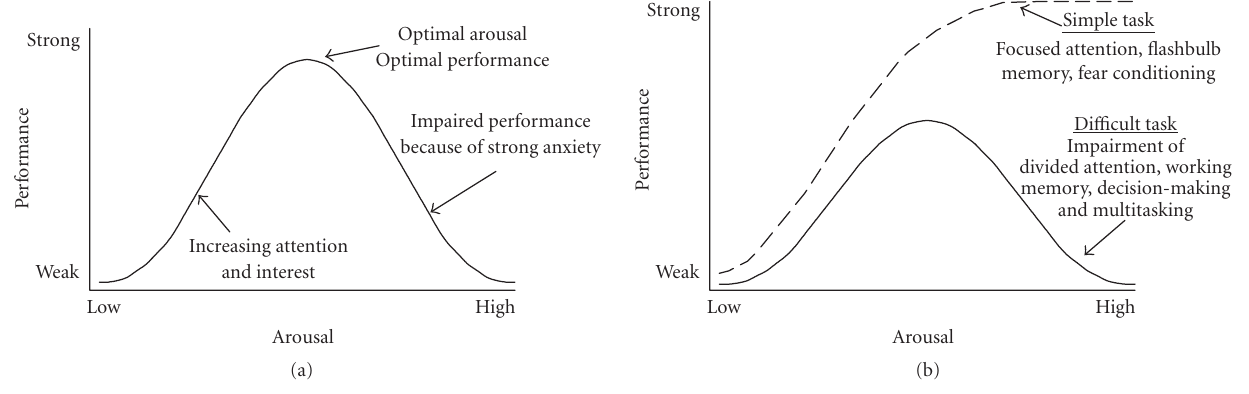
Figure 2: A comparison of the Hebbian version of the Yerkes-Dodson law, as it has been commonly represented for the past 50 years (a), and the original version, based on the actual findings and theorizing of Yerkes and Dodson ([38]; (b)). The Hebbian version incorrectly states that high levels of stress, anxiety, or motivation produce a monolithic impairment of performance. The original version based on the actual [38] Yerkes-Dodson findings takes into account the finding that strong emotionality can enhance performance under “simple” learning conditions, such as when learning involves focused attention on a restricted range of cues, and impairs performance under more complex or challenging learning situations, such as in divided attention, multitasking, and working memory tasks. Graph (a) is adapted from 5 decades of publications and books, for example, Hebb [53], Loftus [54], and Radvansky